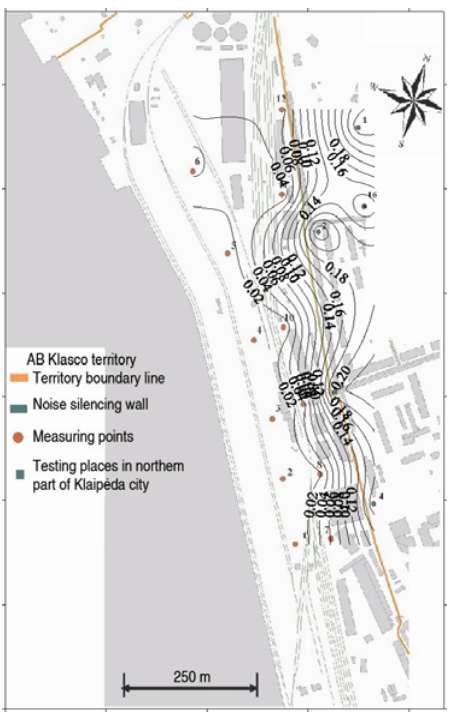
Fig 7 . Dustiness in the daytime in October Fig 8 . Dustiness in the daytime in